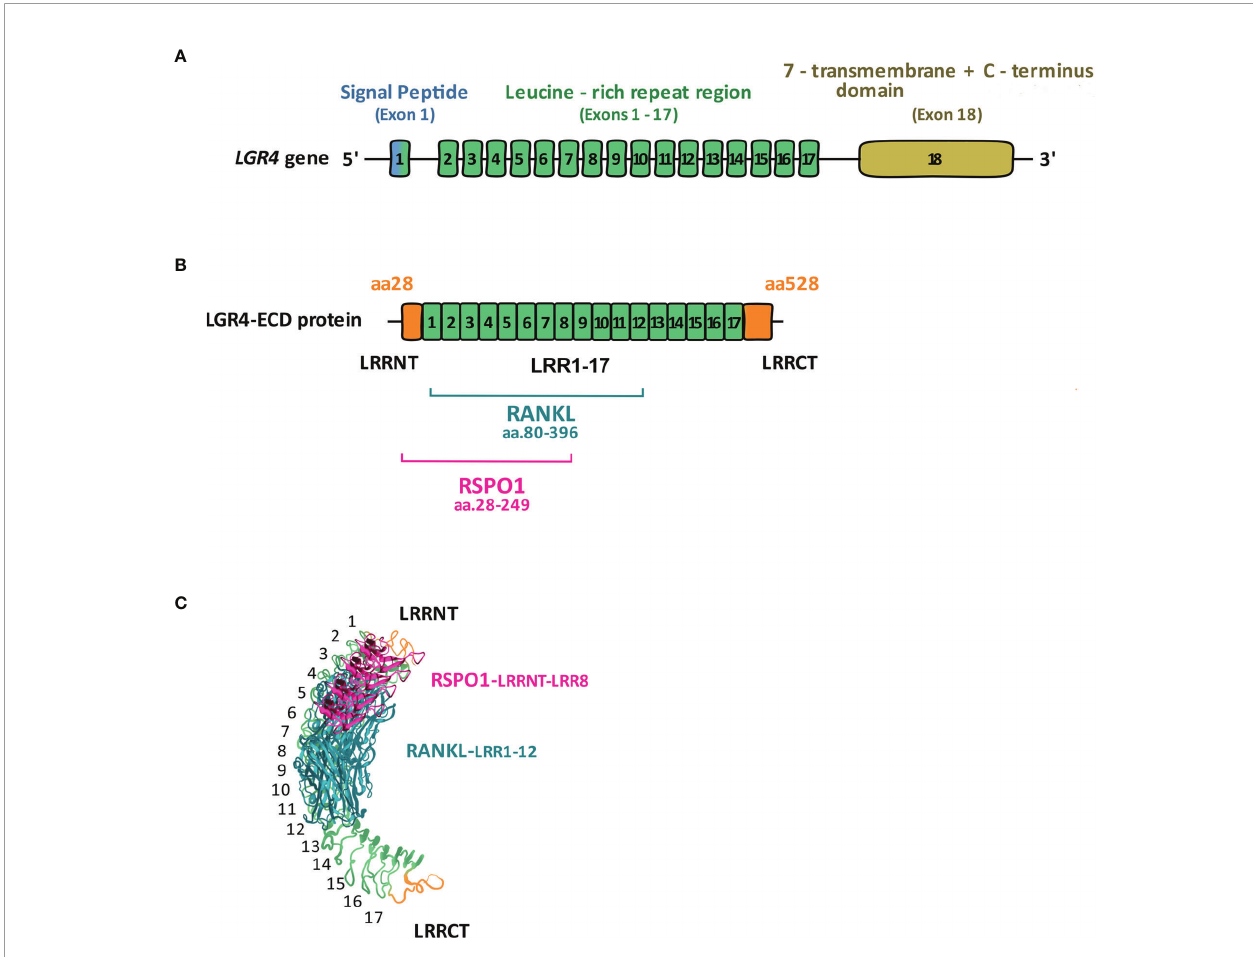
FIGURE 1 | LGR4 gene and protein structure. (A) LGR4 gene contains three main domains: leucine-rich repeats-containing N-terminal domain encoded by exons 1-17, responsible for binding ligands (RSPOs, NORRIN, RANKL); seven-transmembrane (7TM) domain encoded by exon 18, anchoring the receptor within the cell membrane; C-terminal domain encoded by exon 18, responsible for signal transduction. (B) Full-length LGR4 is composed of 951 aa, of which LGR4-ECD comprises aa. 28-528. Within LGR4-ECD aa.28-249 (LRRNT-LRR8) are responsible for RSPO1, whereas aa.80-396 (LRR1-12) for RANKL binding [modi fi ed from reference (11)]. (C) 3D structure of LGR4-ECD binding to RSPO1 and RANKL [modi fi ed from